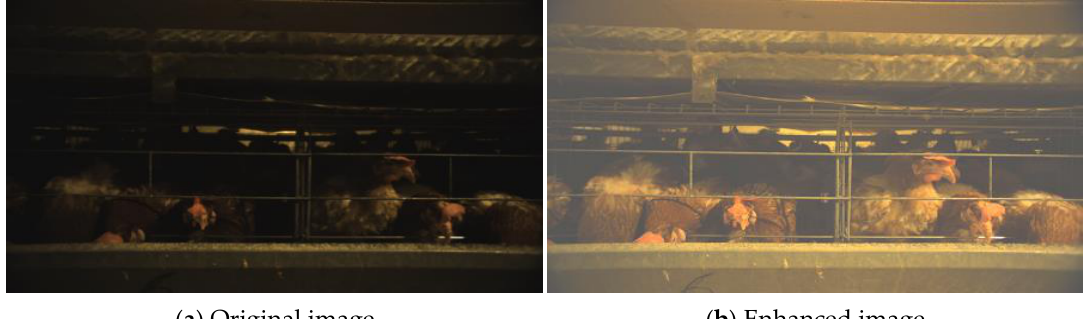
Figure 1. T he image acquisition system and housing condition of laying hens. Figure 1. The image acquisition system and housing condition of laying hens.